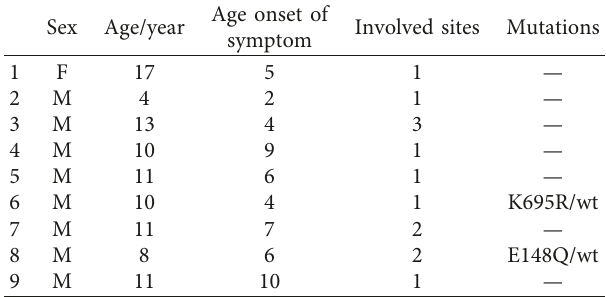
Table 2: Summary of patient